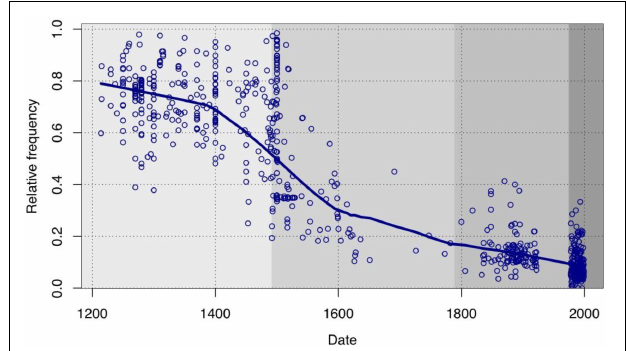
FIGURE 2 | Evolution of the relative frequency of the construction ser “to be” + resultative participle (from Sánchez Marco, 2012: 99, reproduced by kind permission of the